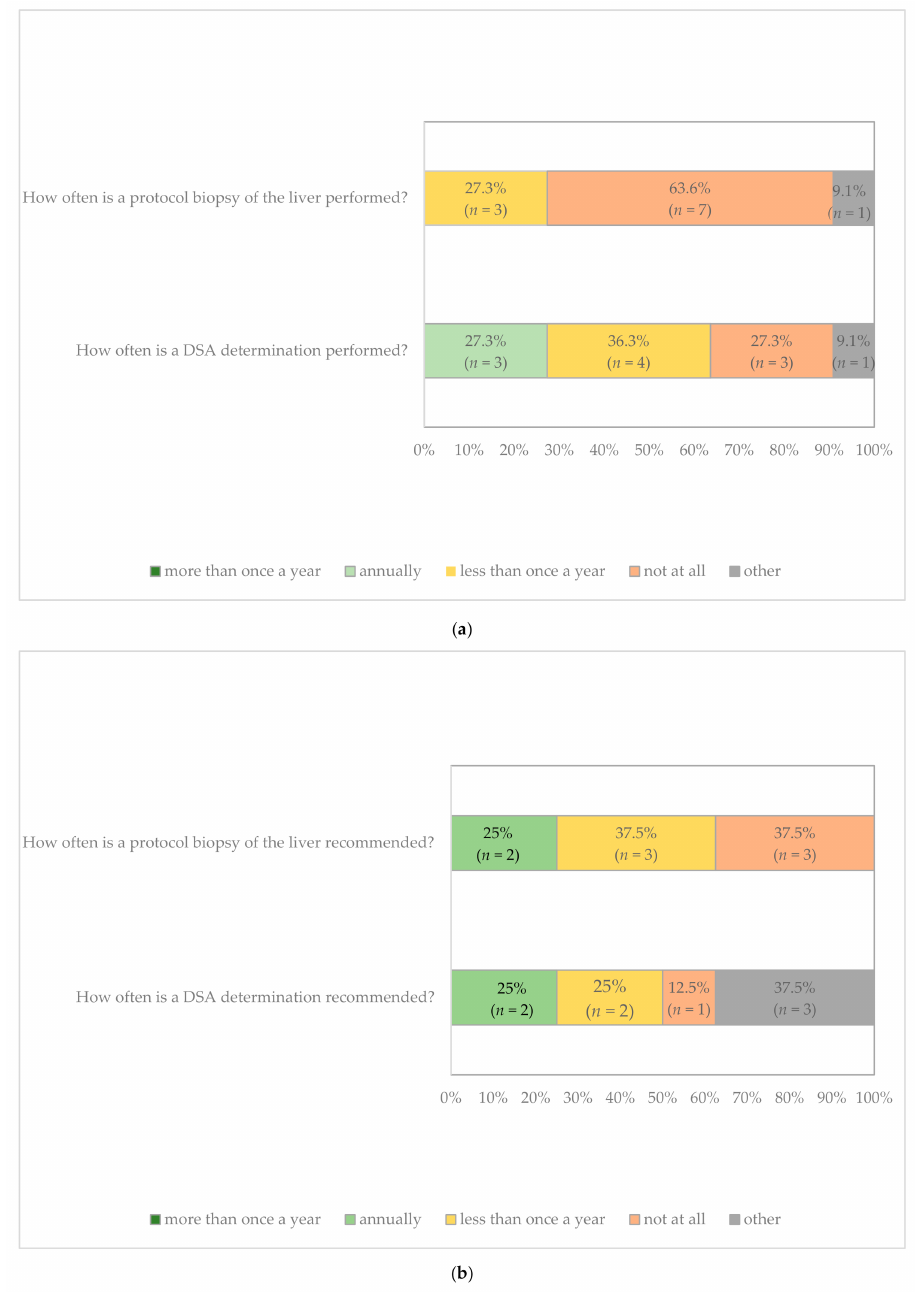
Figure 3. Follow-up procedure at LT centers. ( a ) Current state for protocol biopsy of the liver and DSA (donor-specific antibody) monitoring ( n = 11). ( b ) Target state for protocol biopsy of the liver and DSA monitoring ( n =